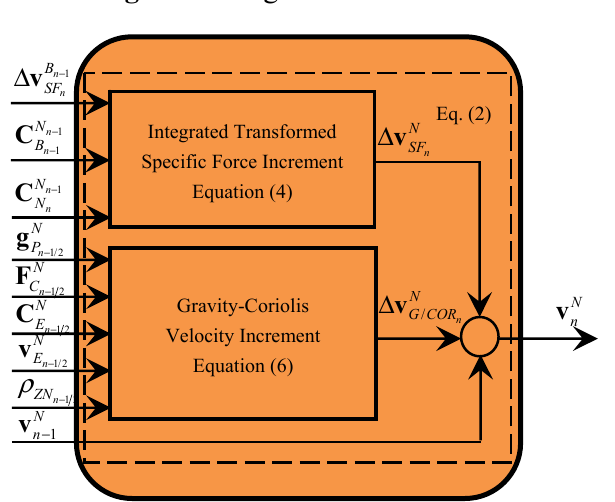
Figure 7. Diagram of module